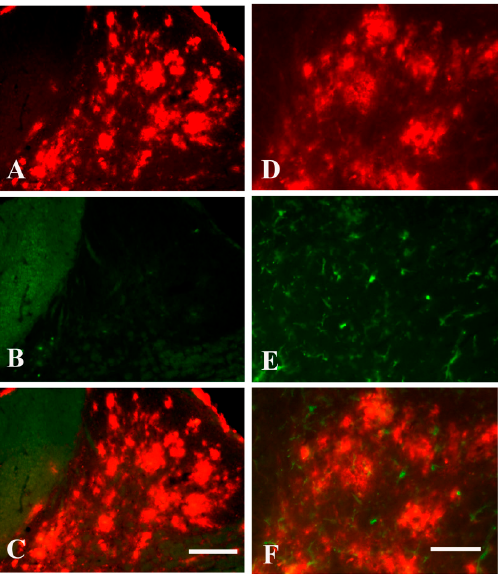
Figure 2. Characterization of A β plaques in the spinal cord of TgCRND8 mice at the age of 20 months. ( A – C ): Double labeling of A β (red)/thioflavin S (green) revealed the A β plaques are thioflavin S negative, indicating the plaques are diffuse plaques. ( D – F ): Double labeling of A β (red)/IBA-1 (green) revealed no activated microglia (green) in the immediate vicinity of A β plaques (red) in the spinal cord. Scale bar in ( C ), 100 µ m. Scale bar in ( F ), 75 µ m. Molecules 2021 , 26 , x FOR PEER REVIEW